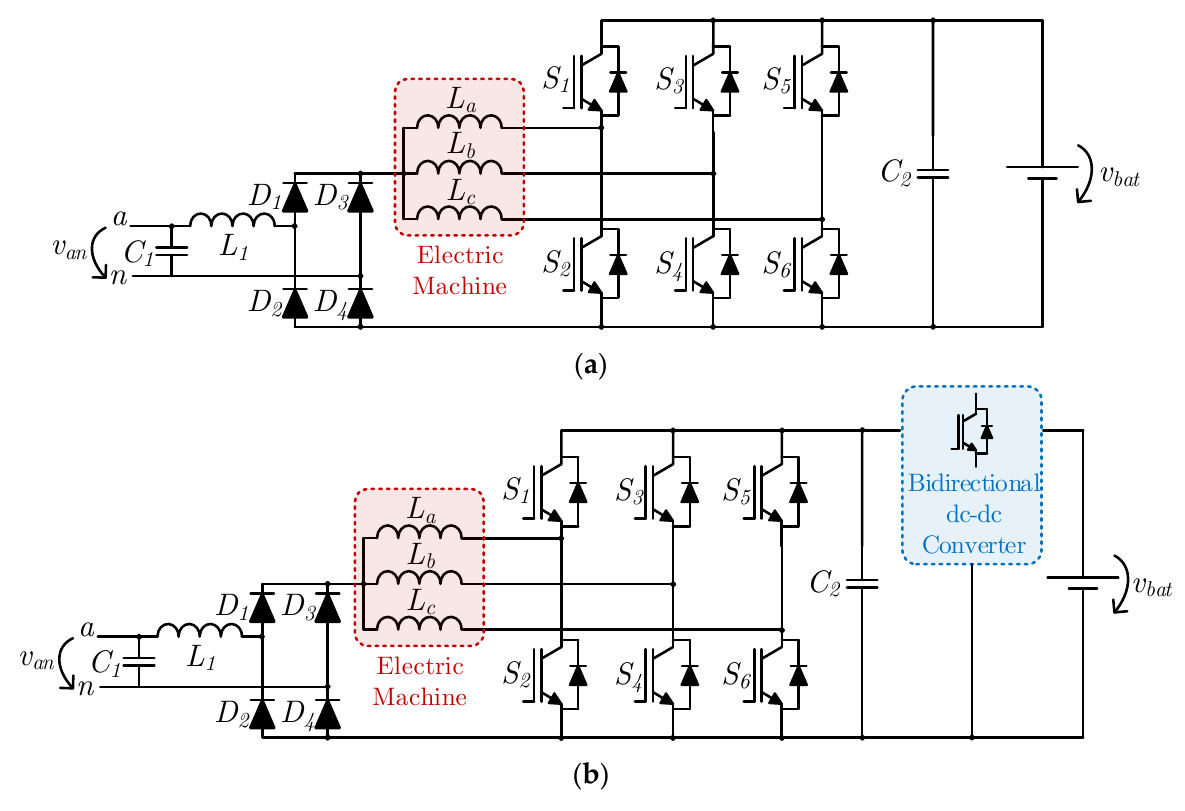
Figure 4. EV IBCs proposed by: ( a ) L. Solero in 2001 [15]; ( b ) G. Pellegrino et al. in 2010 [16].